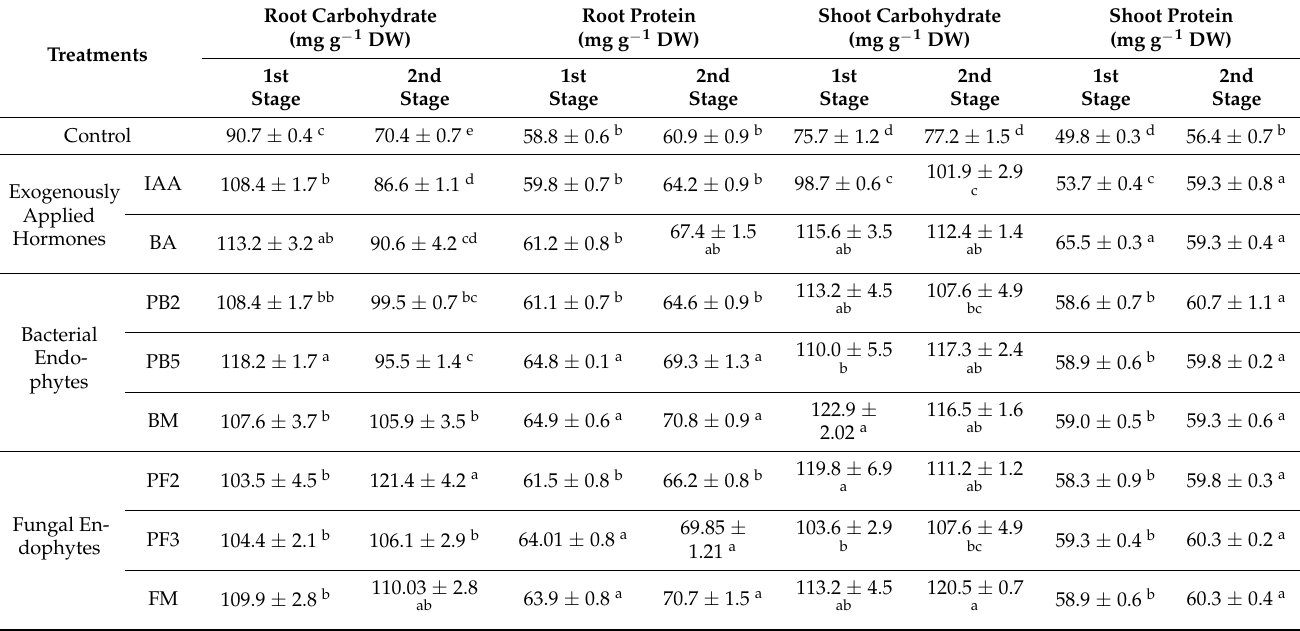
Table 4. Effect foliar spraying of exogenously applied hormones and microbial endophyte metabolites on carbohydrates and protein contents of common bean